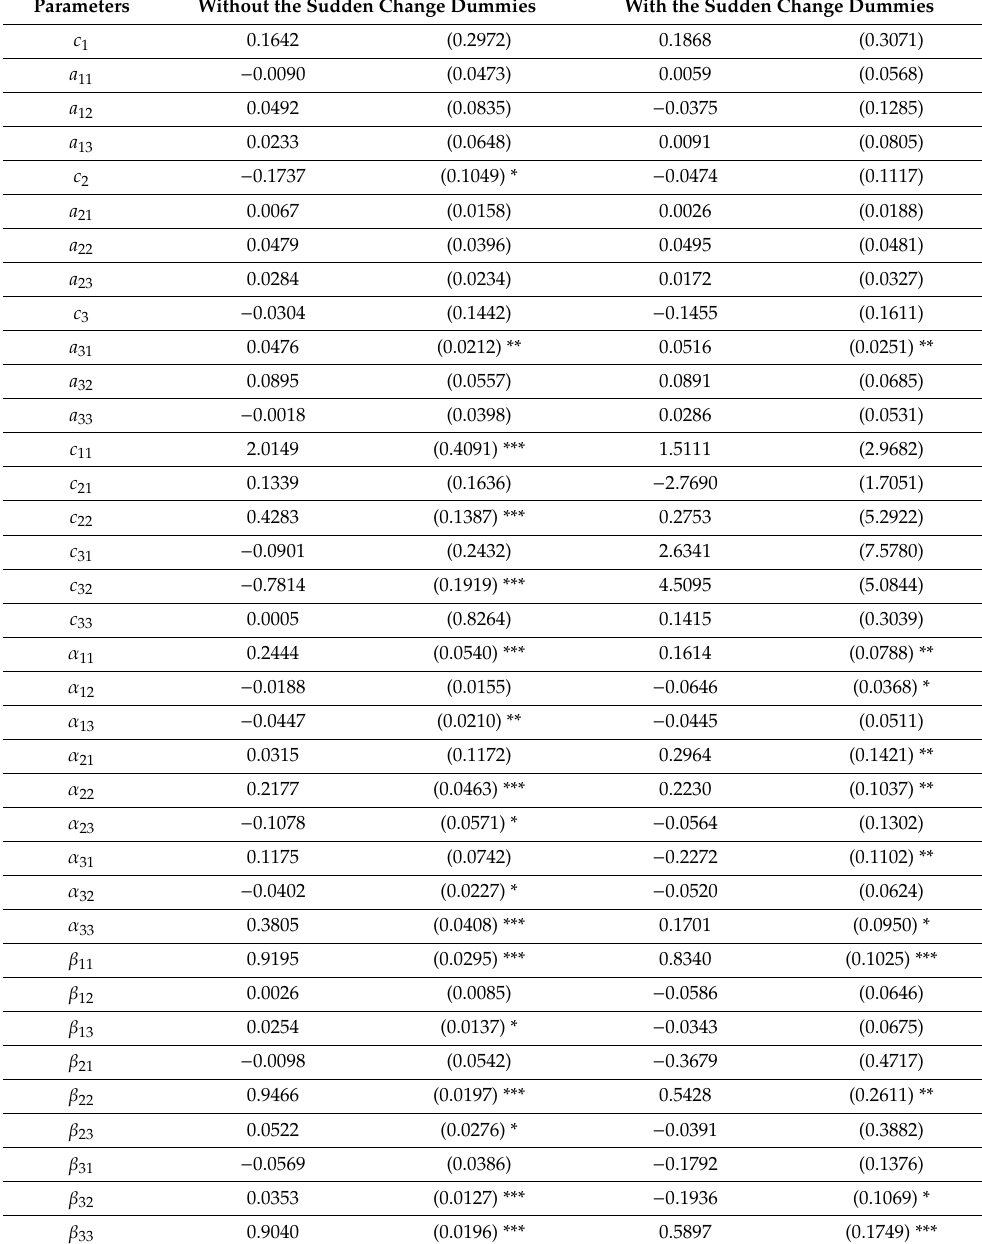
Table 6. Estimation results of VAR(1)-GARCH(1,1)-BEKK model for the EUA, biofuel, and Brent oil